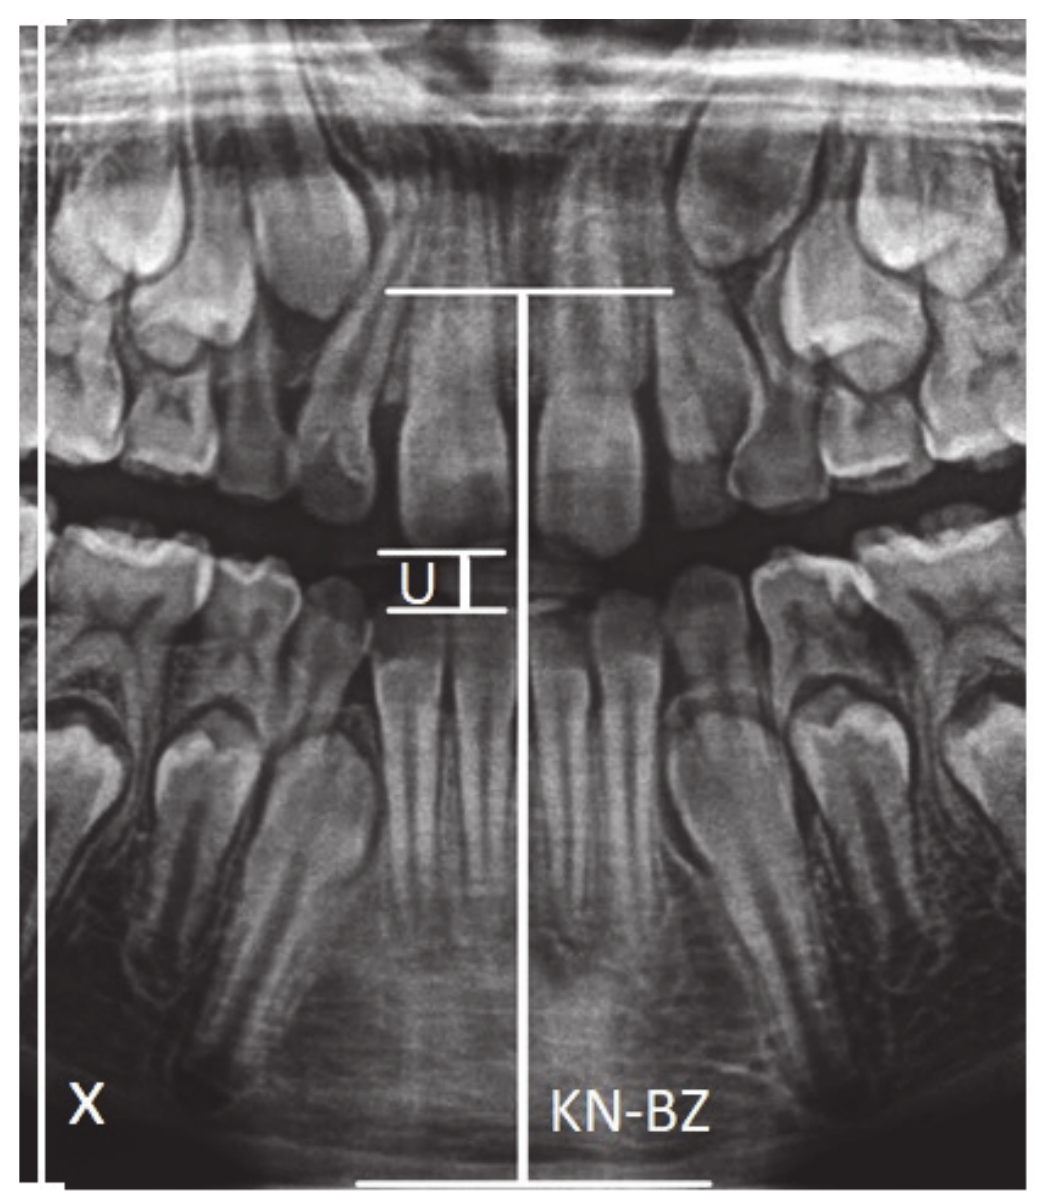
Figure 1. Graphic representation of the KN-BZ and U distances (KN-BZ—Distance of the anterior nasal spike-KN from the mandibular margin-BZ; U—Width of the mouthpiece of the X-ray equipment). S11-W11 is the distance between point S11 (on the incisal margin of tooth 11) from point W11 (the point on the alveolar margin in the line drawn through the point on top of the alveolus perpendicular to the X